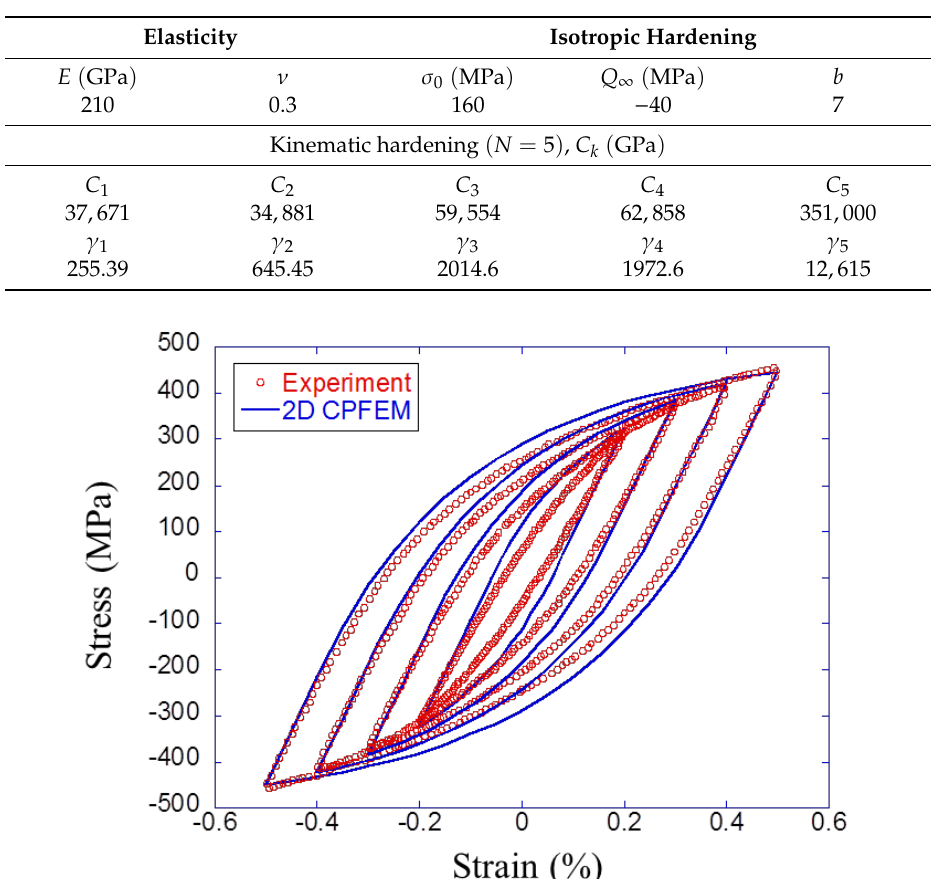
Figure 7. Experimental and calibrated stress–strain hysteresis loop for pearlite steel. Table 4. Finite element analysis parameters of ferrite. Elastic coefficients are taken from the literature [26].